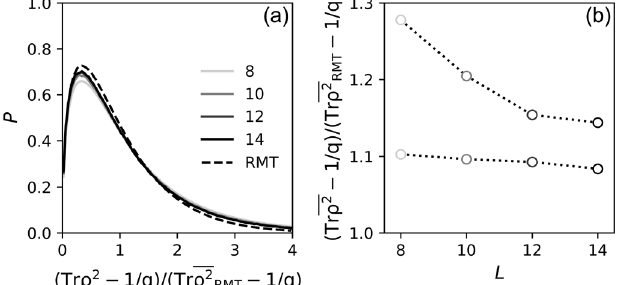
FIG. 20. Fluctuations of the one-site eigenstate purities, − 1 =q . In Tr ρ 2 − 1 =q , in units of the RMT average, Tr ρ 2 RMT panel (a), the solid lines show the probability distribution P of ð Tr ρ 2 − 1 =q Þ = ð Tr ρ 2 − 1 =q Þ for systems of various sizes L RMT (legend), and with open boundary conditions. The dashed line is the distribution within RMT, calculated from Haar-random 2 8 × 2 8 unitary matrices. In panel (b), we show the mean as a function FIG. 19. Circuit diagrams of R x ð t Þ (left) and R 0 x ð t Þ (right). Away from x , R x ð t Þ has the same trace structure as K ð t Þ . On the of L for periodic (lower points) and open (upper points) boundary upper right of the figure, the illustration shows the forward (outer) conditions. For open boundary conditions, we exclude data from and backward (inner) single-site orbits, relevant to only site x in two sites at each of the two ends of the R 0 ð t Þ and the other ( L − 1 ) sites in R ð t Þ . On the lower right, the x x illustration shows the concatenation of forward and backward paths relevant to only site x in R x ð t Þ and to the other ( L − 1 ) sites in R 0 x ð t Þ .